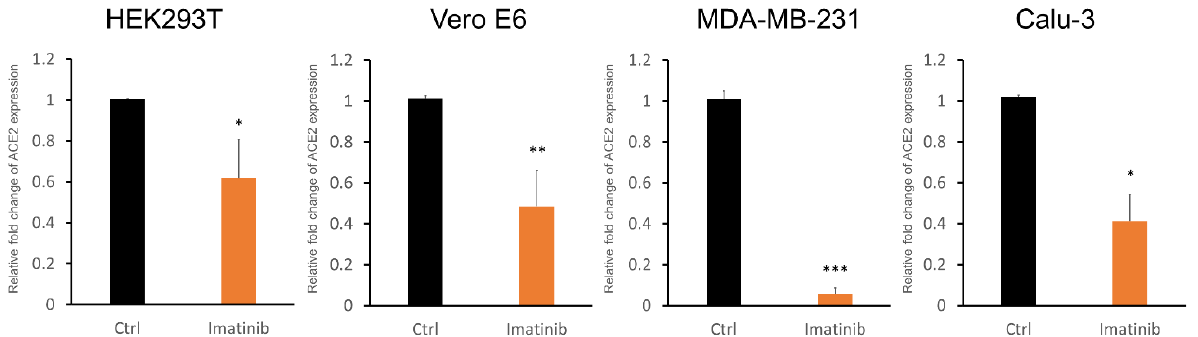
Figure 2. Downregulation of the endogenous ACE2 gene by imatinib treatment. The indicated cell lines were mock-treated or treated with imatinib (at 5 µ M for 24 h). The mRNA expression of the endogenous ACE2 gene was measured by qRT-PCR. For each cell line, the data obtained from three independent experiments were plotted. Bars, standard deviation. The p -values determined by Student’s t -tests are indicated by asterisks. * p < 0.05; ** p < 0.01; *** p < 0.001.